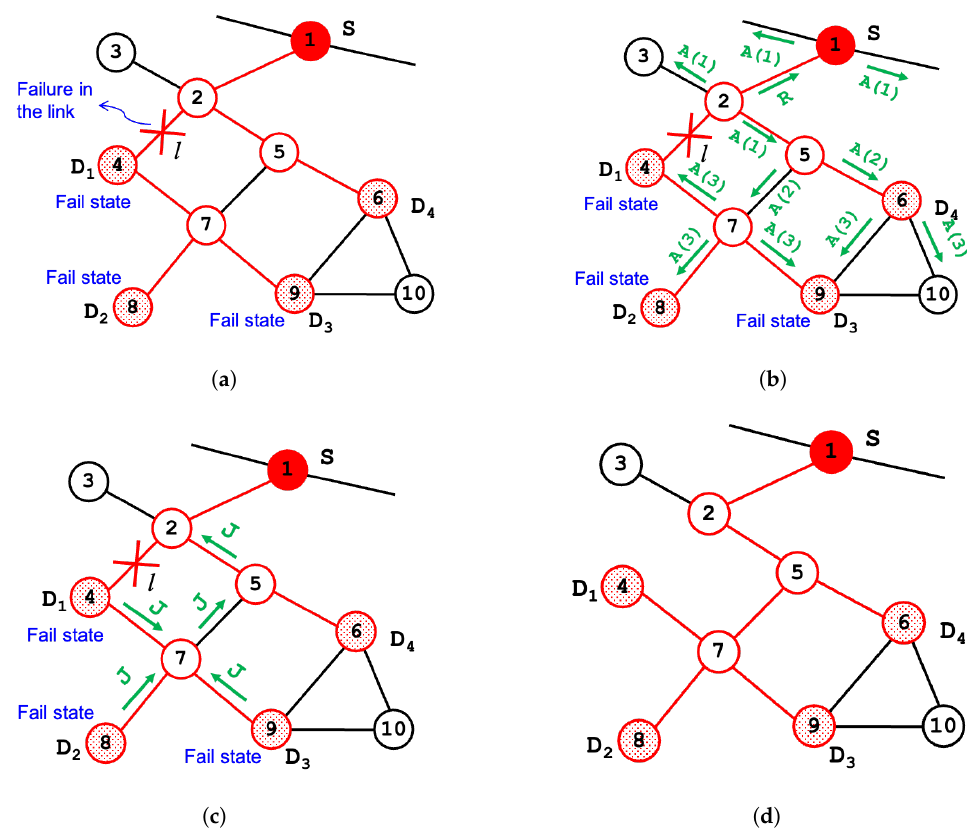
Figure 4. Example of the MDT adaptability: ( a ) a failure in link l disconnects leaves D 1 , D 2 , and D 3 ; ( b ) upstream node 2 starts looking for the downstream leaves using a type-A 2 message; ( c ) disconnected leaves join the new least cost branching paths to the upstream node 2; ( d ) leaves are now re-connected and can release previous